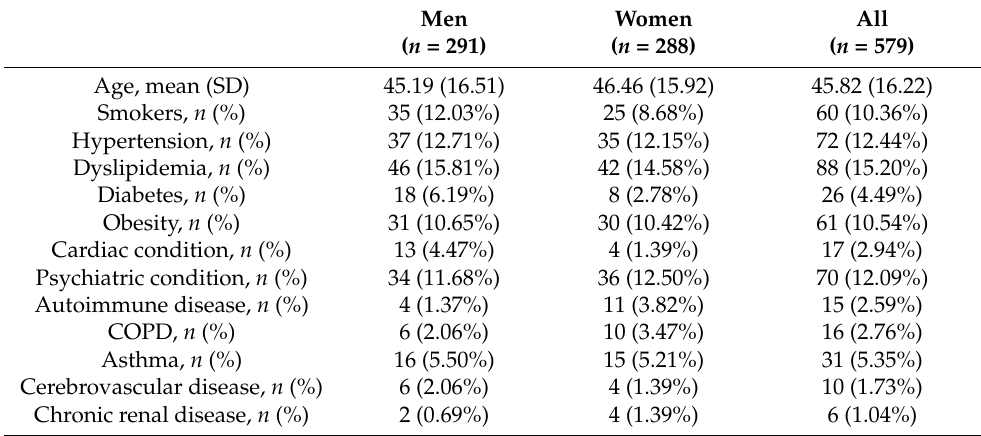
Table 1. Characteristic of the study population.